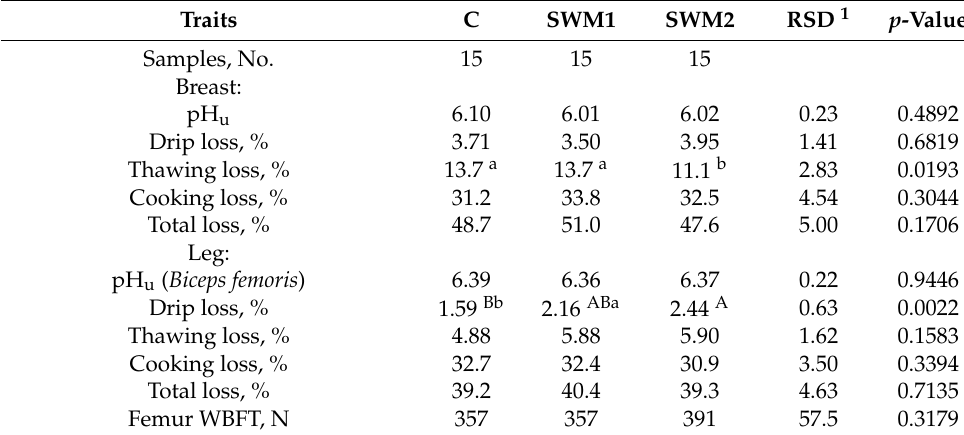
Table 6. Effect of the dietary inclusion either with 0% (Control) or 4% of defatted silkworm ( Bombyx mori L.) meal during starter (SWM1) or grower and finisher (SWM2) phase on pHu, drip loss, thawing loss and cooking loss of chicken breast and leg meat, and femur bone Warner–Bratzler Fracture Toughness